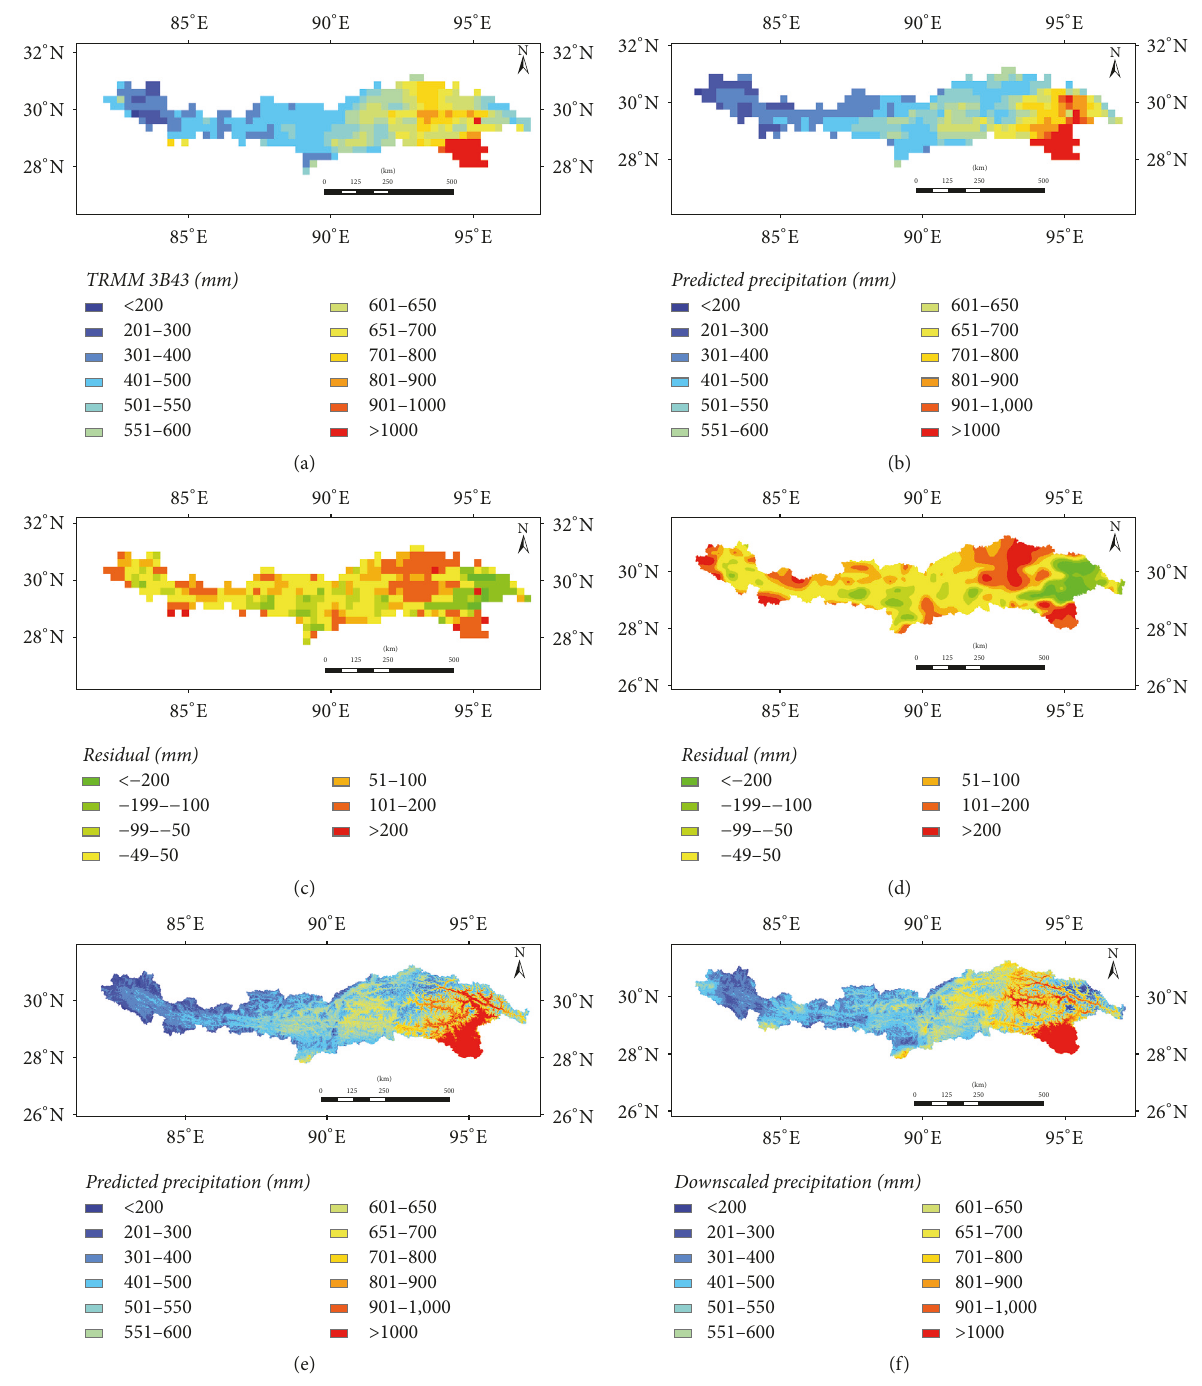
Figure 5: TRMM 3B43 annual mean precipitation downscaling processes from 2001 to 2014: (a) TRMM 3B43 annual mean precipitation from 2001 to 2014; (b) predicted annual precipitation with low spatial resolution; (c) residual data with low spatial resolution; (d) residual data with high spatial resolution; (e) predicted annual precipitation with high spatial resolution; (f) downscaled annual mean precipitation at 1 km × 1km resolution.